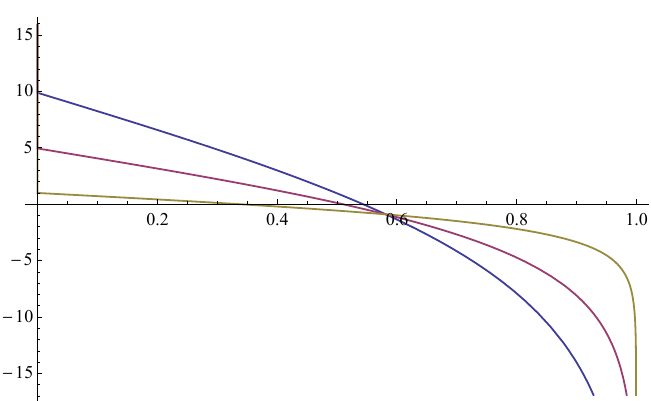
Figure 20: F as a function of r SFM α = 1